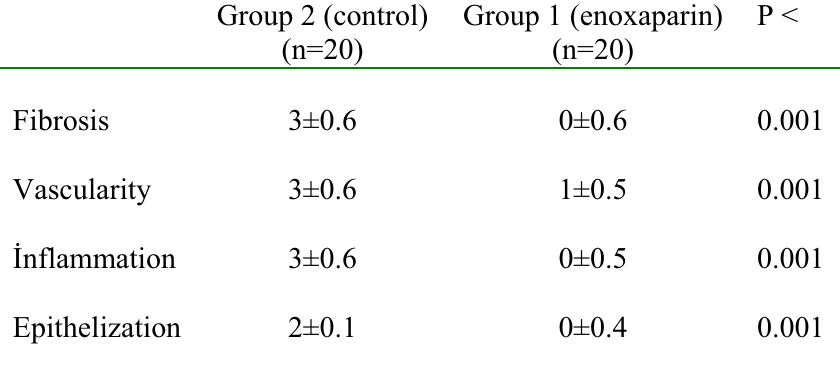
TABLE 1 - The values of histopathologic data were analyzed by Mann-Whitney